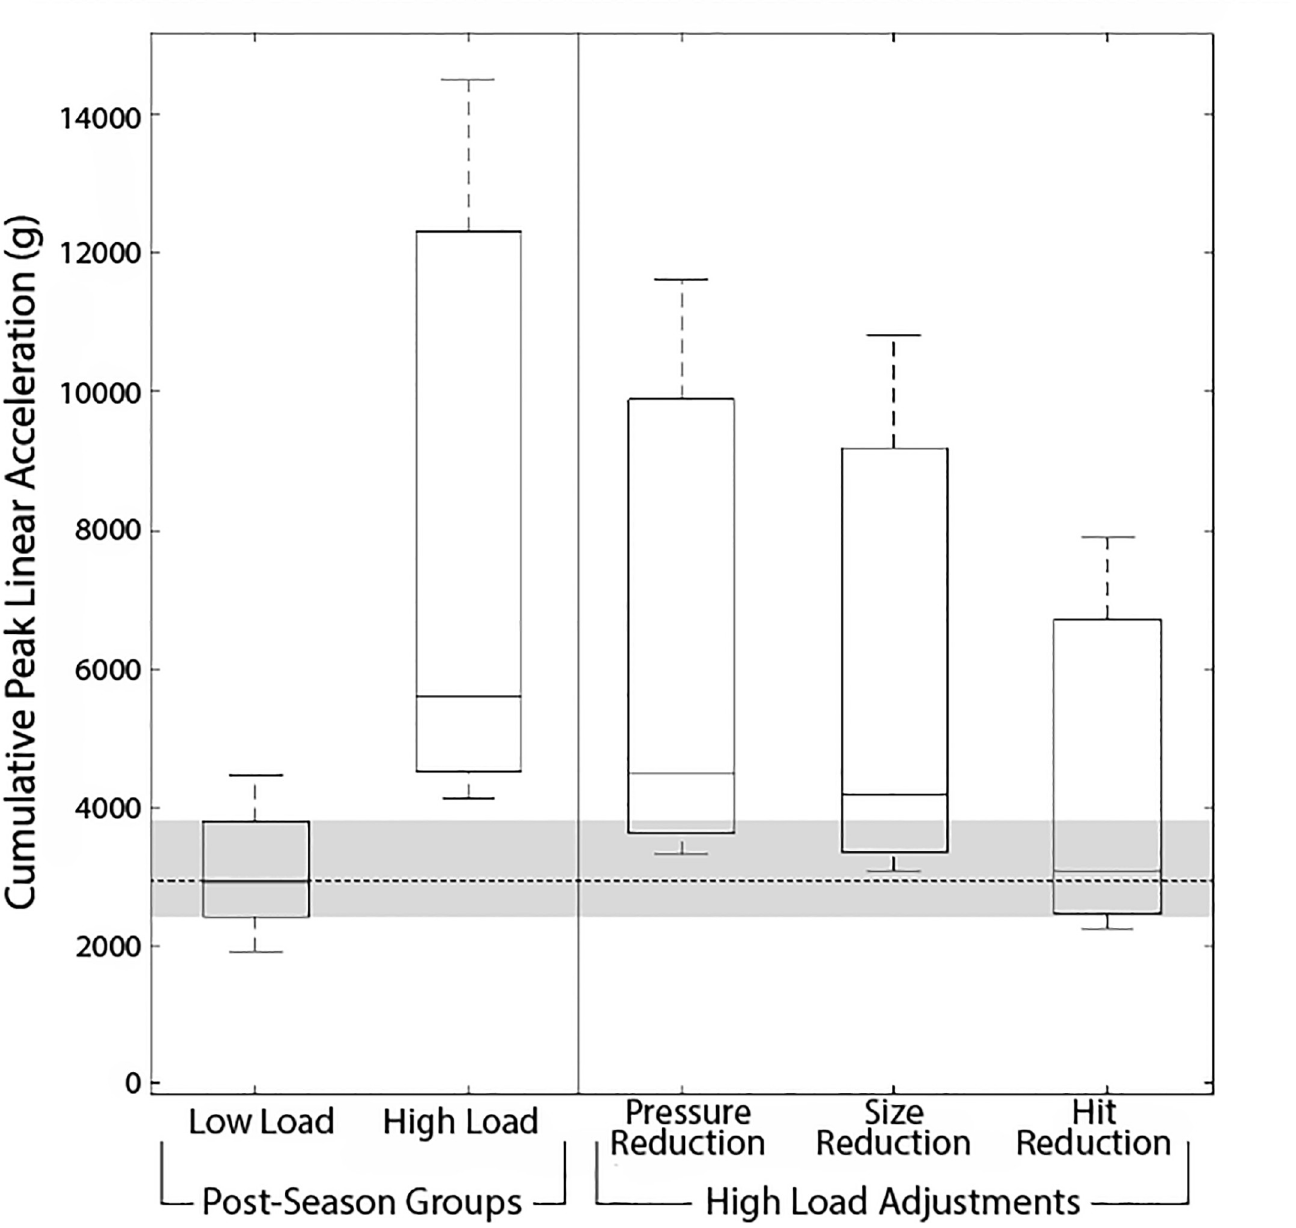
Fig 6. Svaldi et al.’s “High Load” and “Low Load” groups from a soccer season (High Load percentiles: 25th = 4515 g, 50th = 5615 g, 75th = 12313 g; Low Load percentiles: 25th = 2425 g, 50th = 2930 g, 75th = 3800 g) [36]. Post-season adjustments to the High Load group: 19.7% reduction from decreasing inflation pressure from 1.10 bar (16 psi) to 0.55 bar (8 psi), 7.1% reduction from downsizing a size 5, 0.55 bar (8 psi) ball to size 4.5, 0.55 bar (8 psi) ball (Table 3), and a 20% reduction in number of hits based on average PLA per hit (Adjusted High Load percentiles: 25th = 2463 g, 50th = 3063 g, 75th = 6718